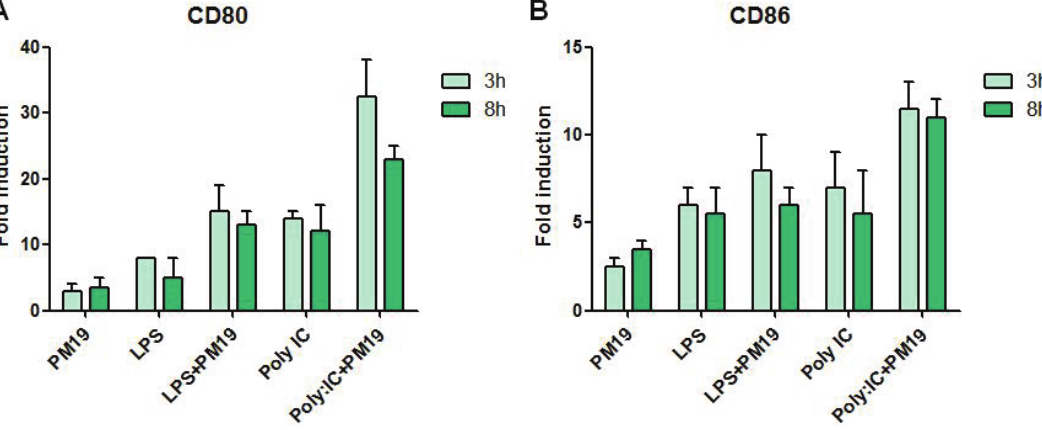
Figure 6. Costimulatory molecules CD80 ( A ) and CD86 ( B ) expression following 3 or 8 h treatment with PM 19 . Data are shown as fold changes expression from the untreated sample. Experiments were conducted on iMDDCs from 3 healthy donors. Data represent the mean ±